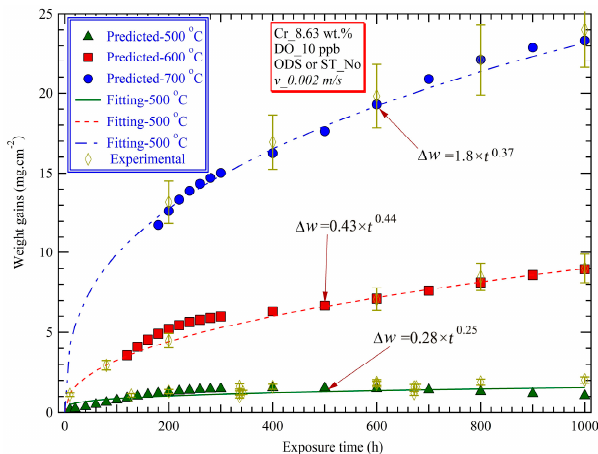
Figure 4. ANN-Predicted and experimental weight gains versus exposure time and the fitting curves.